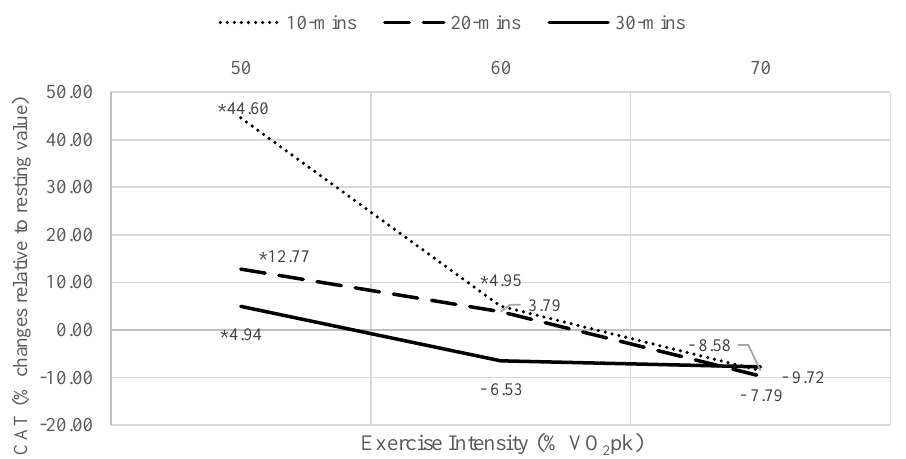
Figure 1. Percentage of MDA changes at 50%, 60%, and 70% V̇ O 2 pk during exercise. * significantly different from 70% V̇ O 2 pk ( p < 0.05).